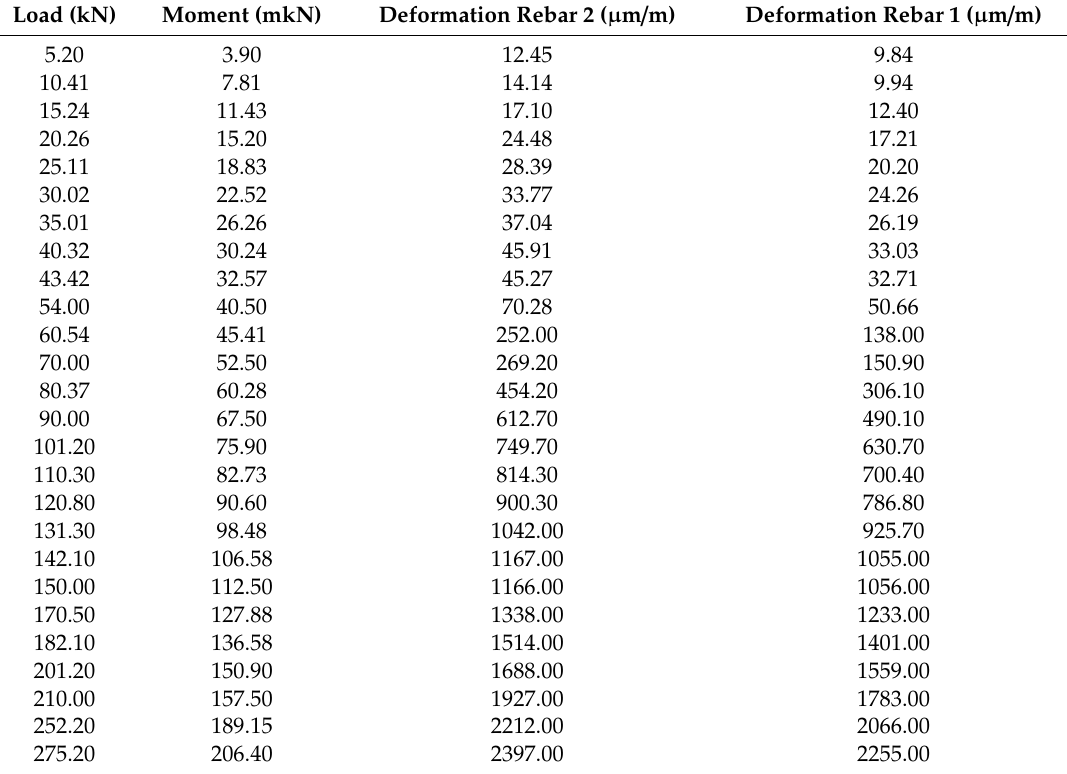
Table 7. Relation between loads applied and deformation of the rebars 1 and